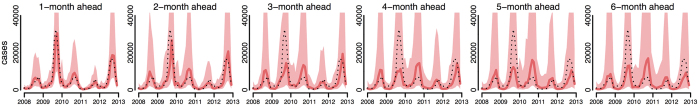
Prospective predictions with uncertainty.Forecasts from the national (1,0,0)(3,1,0)12 model with 95% Confidence Intervals are compared to reported dengue incidence (black, dashed lines). The (1,0,0)(2,1,0)12 model and models for each state are shown in Figure S2.